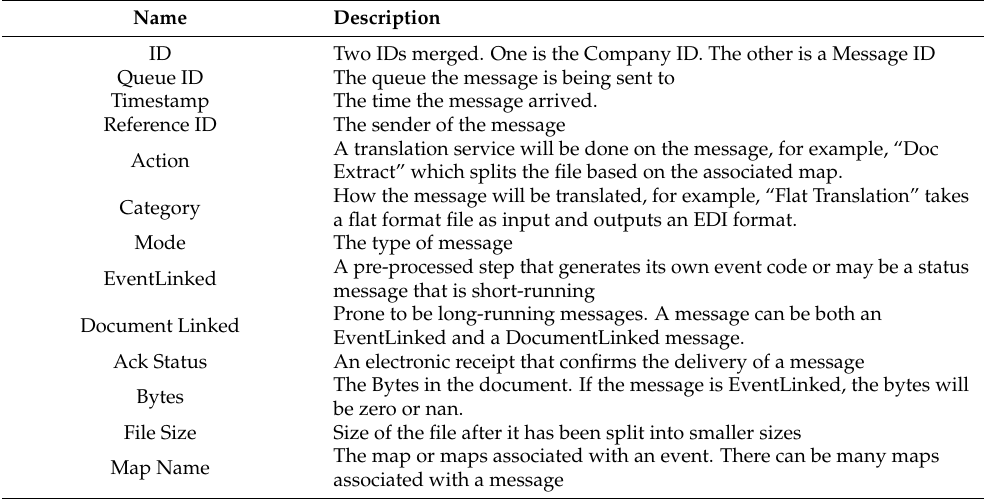
Table 5. Message attribute data